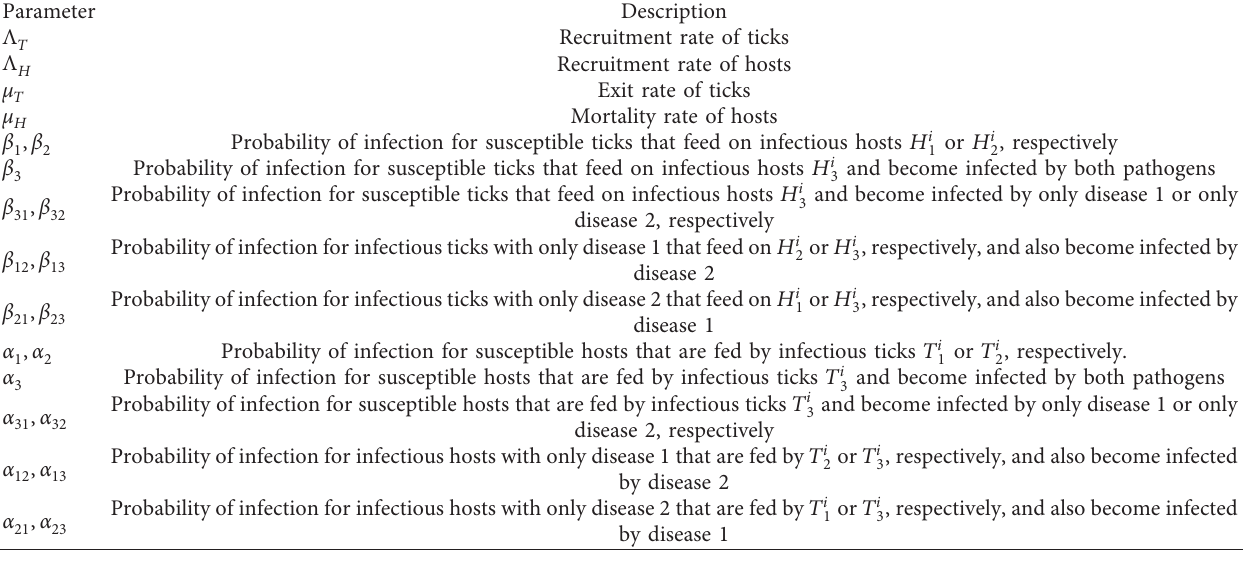
Table 1: Model parameters and